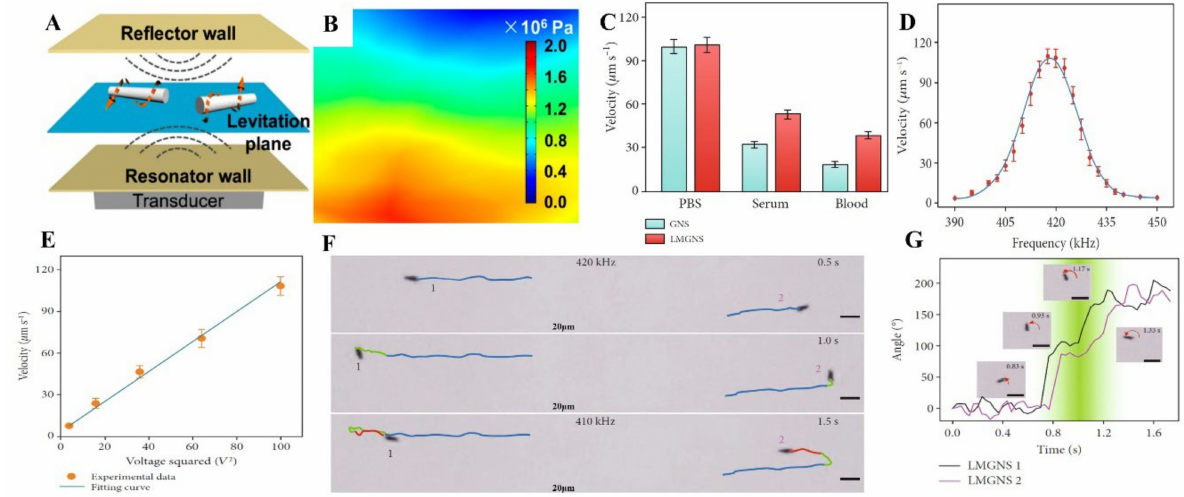
Figure 13. Ultrasonic propelled MLMTs. ( A ) Schematic illustration of propulsion of the asymmetric MLMTs in acoustic field. ( B ) COMSOL simulation of the generated pressure gradient along MLMTs [9]. ( C ) The time-lapse images of the direct control of MLMTs by frequency of the acoustic field. ( D ) The relationship between the velocity of MLMTs and frequency of the acoustic field. ( E ) The relationship between the velocity of MLMTs and the applied voltage of acoustic field. ( F ) The direction control of MLMTs by changing frequency. ( G ) The velocity of MLMTs in PBS, serum, and blood media